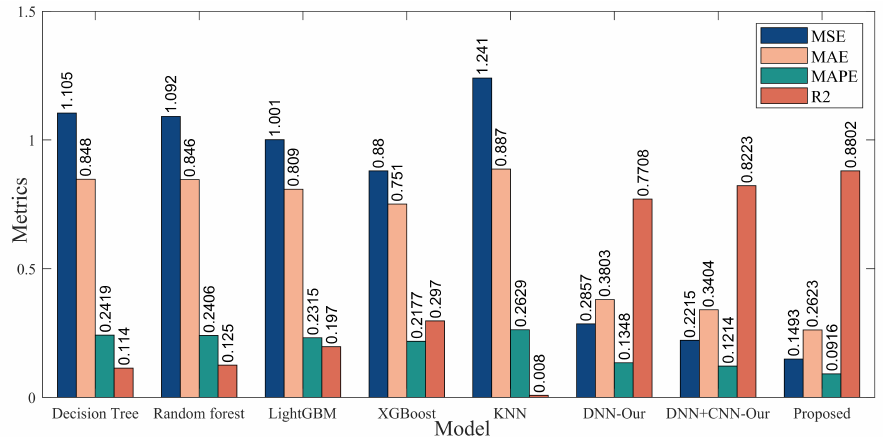
Figure 13. Performance comparison chart with classical machine learning